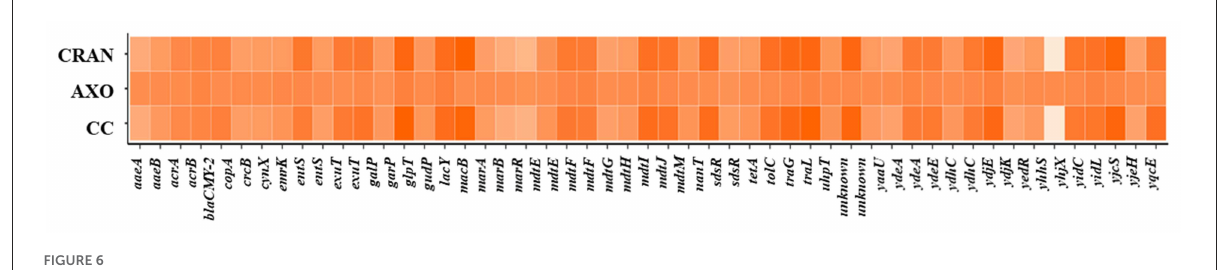
FIGURE6 Cluster analysis of differential gene expression (DEG). Heat maps showing log 2 FC DEGs of antimicrobial resistance genes of E. coli O7:H18 (ST38) treated with 4 mg/mL of CRAN, 4 µ g/mL of AXO, and 4 µ g/mL AXO + 4 mg/mL CRAN (CC) compared to control for 3h.